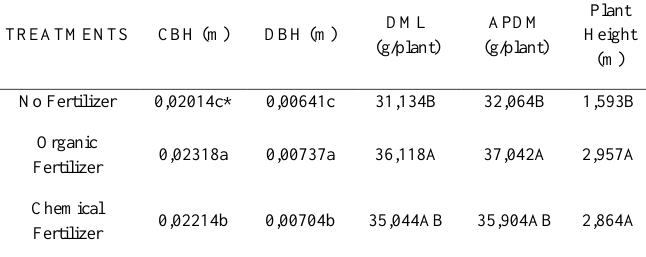
Table 2: Comparison between the means of the variables obtained in the sixth month of planting for the circumference at breast height (CBH), diameter at breast height (DBH), dry mass of leaves (DML), aerial part dry mass (APDM) and height of plant of specie Schizolobium amazonicum in the three treatments analyzed.